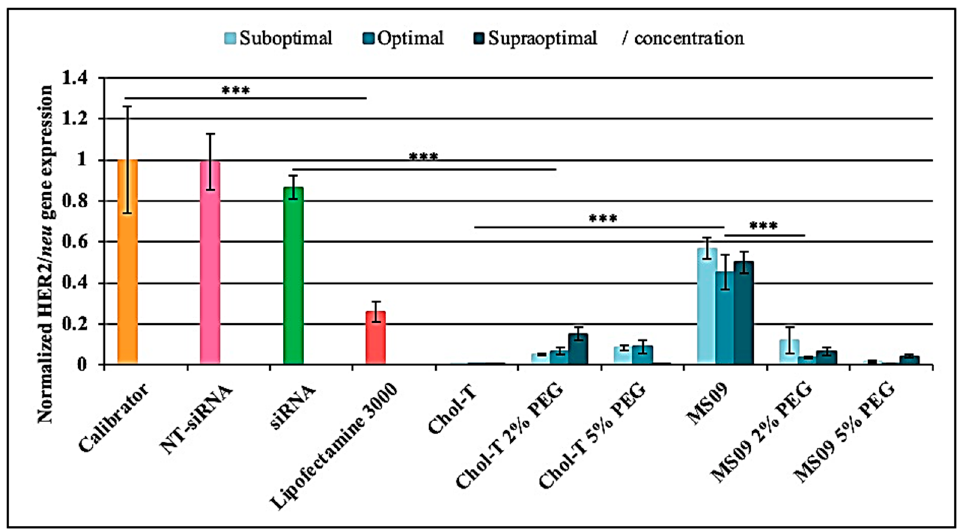
Figure 5. Analysis of HER2/neu gene expression in SKBR-3 cells by qRT-PCR. The vertical axis represents the relative quantification of HER2/neu normalized against GAPDH mRNA level using the comparative quantification algorithm 2- ∆∆ Ct [30]. The mean ± SD of independent experiments (n = 3). *** p < 0.001 was considered statistically significant.